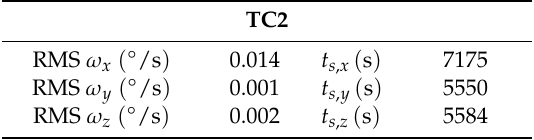
Figure 9. Difference between the actual and estimated angular rates for Test Case 2. Table 6. Root Mean Square of the angular rates estimation error and settling times for Test Case 2.